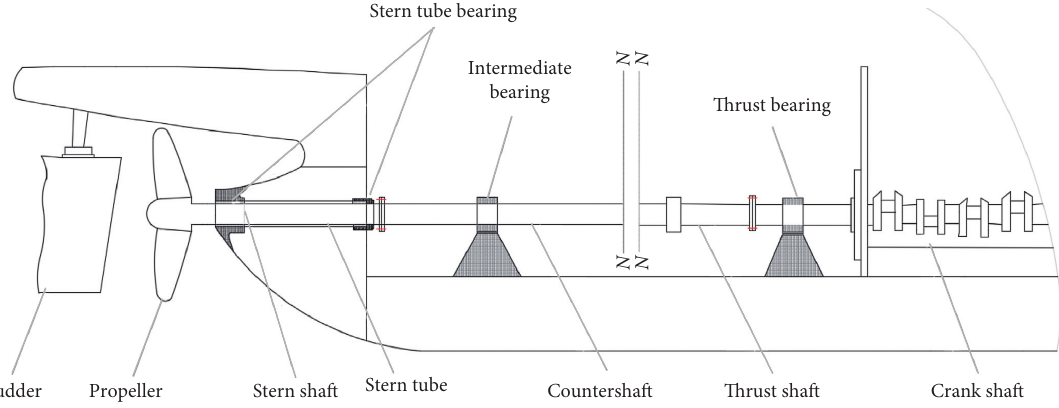
Figure 1: Diagram of marine propulsion